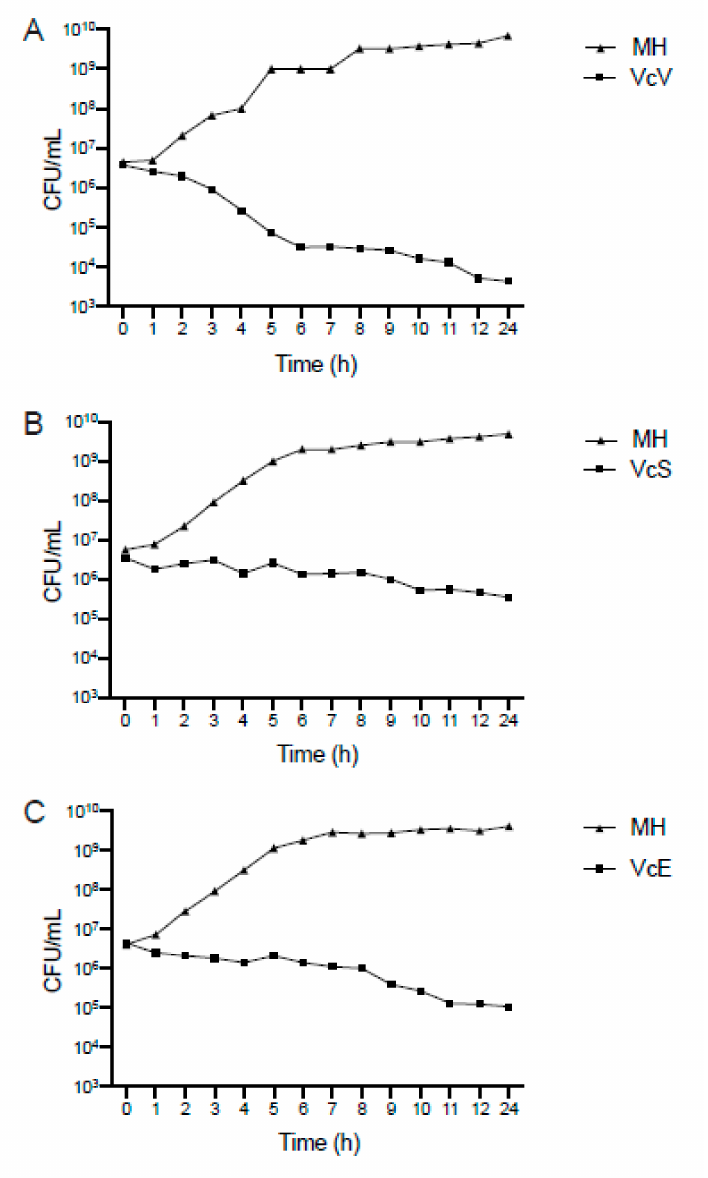
Figure 1. Time-killing curve analysis: ( A ) VcV (104.9 µ g mL − 1 of bioactive polyphenols); ( B ) VcS (40.6 µ g mL − 1 of bioactive polyphenols); and ( C ) VcE (40.3 µ g mL − 1 of bioactive polyphenols). MH: control group (absence of extract). The data corresponds to the median of three biological